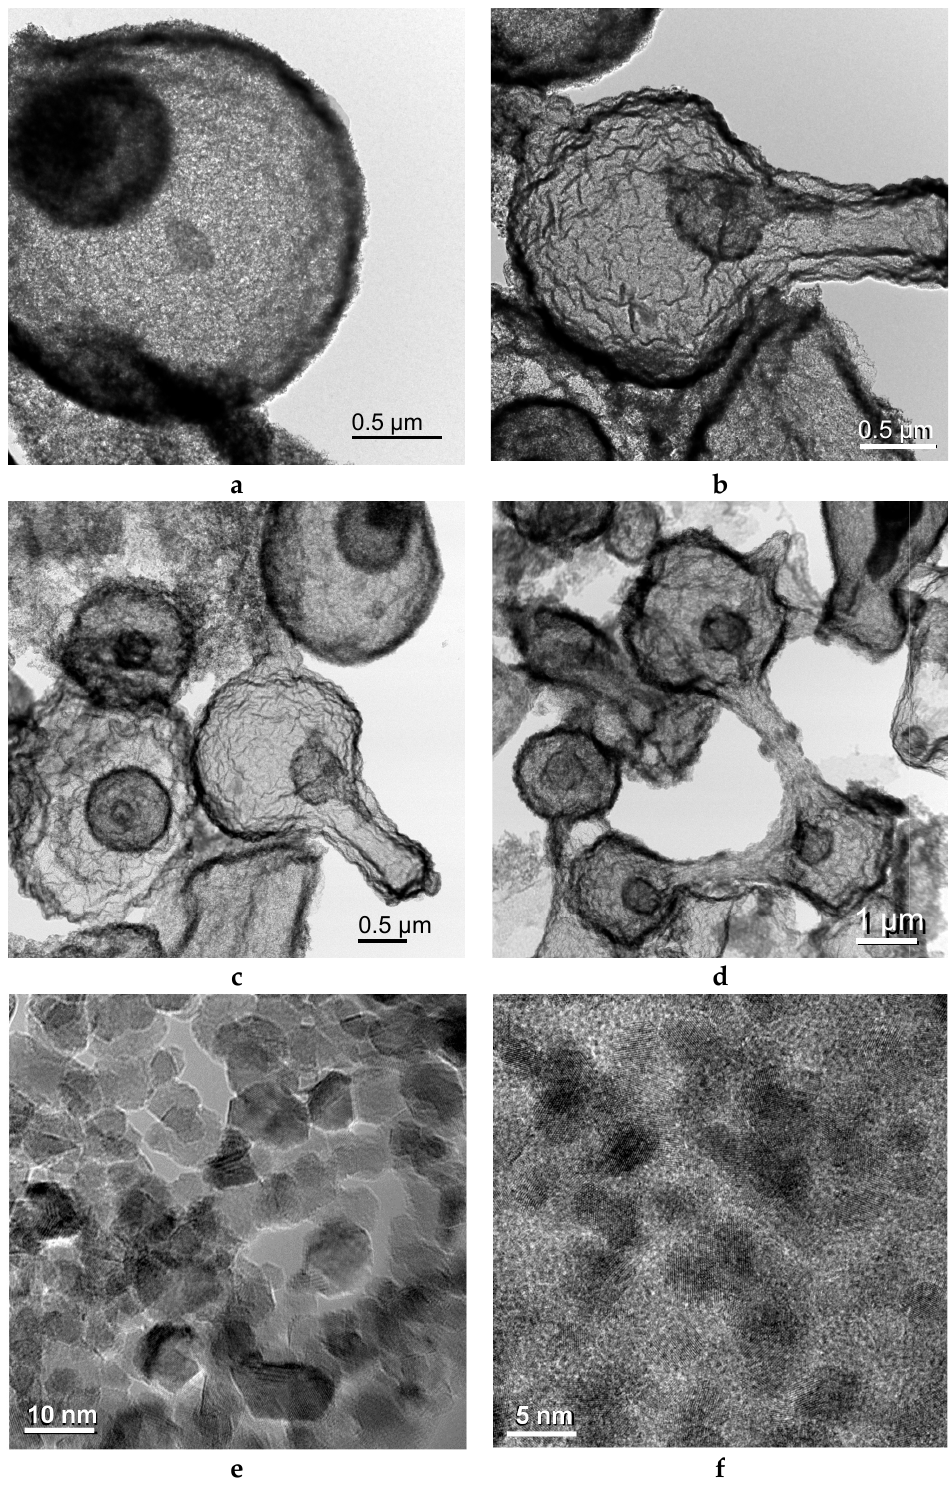
Figure 7. TEM-STEM pictures of hollow nickel oxide microspheres: ( a – d ) general views at rather similar magnifications; ( e – f ) high-resolution TEM pictures at higher magnifications. Metal oxide nanoparticles have been already synthesised through the HTC technique based on starch [35,36] or glucose [2,51]. Titirici et al. [51] also obtained hollow crystalline iron oxide spheres with diameters of 1 µ m, for which both the surface area and the thickness of the shell could be